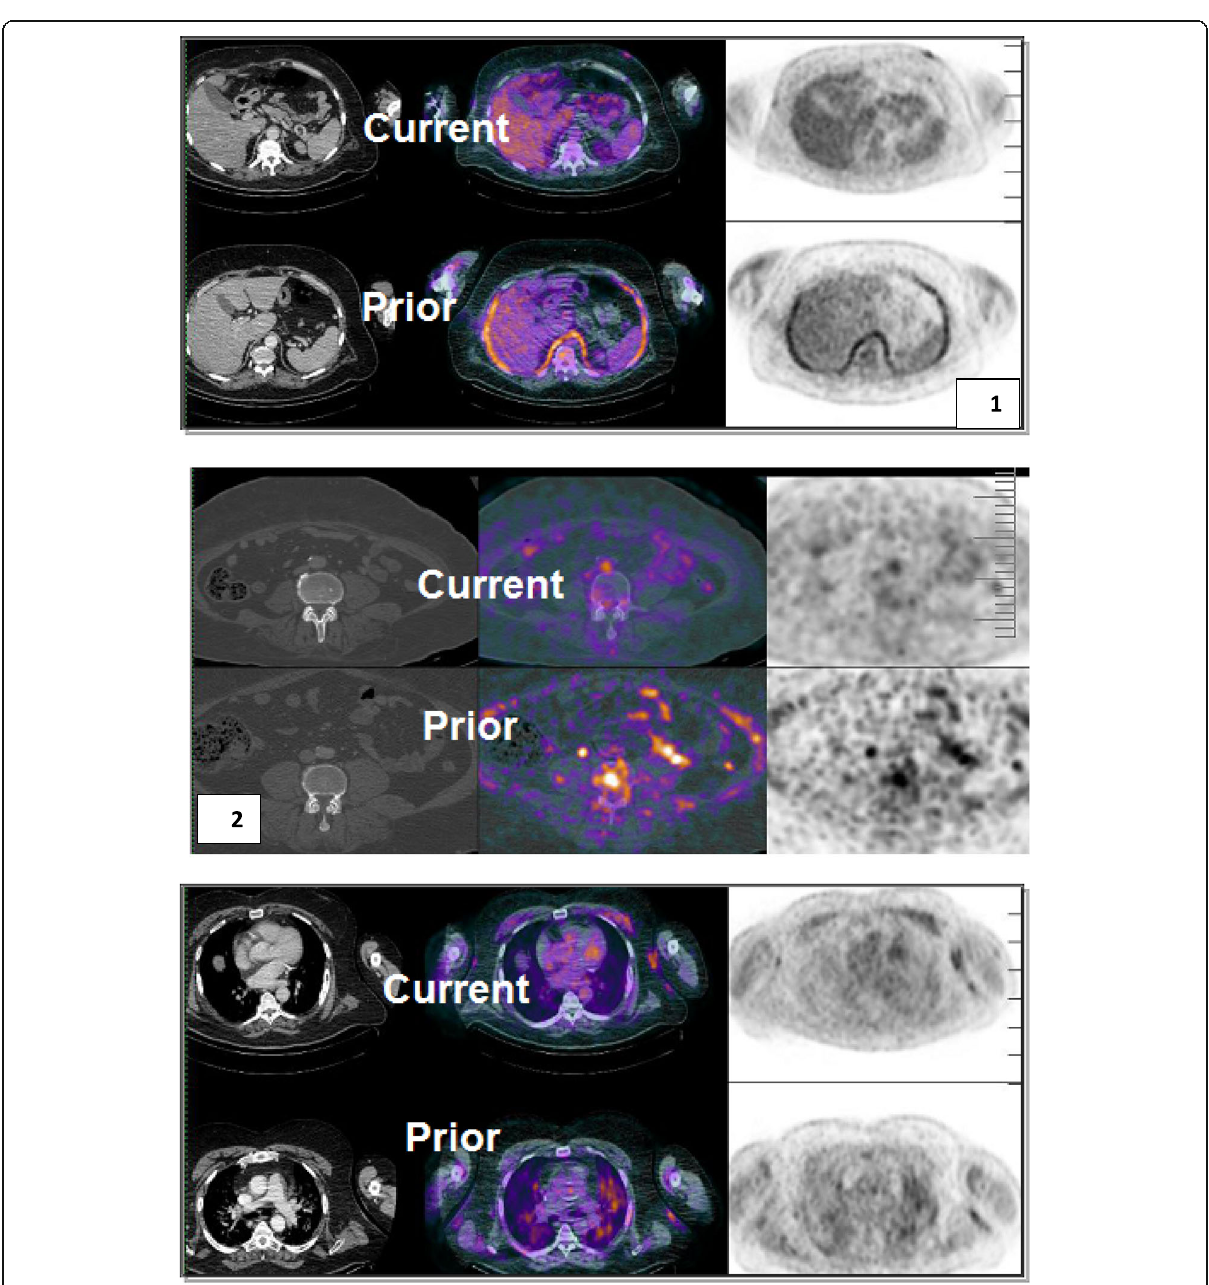
Fig. 3 1 Axial CT, PET, and PET/CT images showing regression of FDG avid chest wall lesions except for left anterior chest wall lesion (skin and subcutaneous tissue). 2 Axial CT, PET, and PET/CT images showing metabolic regression of FDG avid osseous lesions, involving sternum, vertebrae, pelvic bones, and femora. 3 Axial CT, PET, and PET/CT images showing metabolic regression of reticulonodular lung infiltration. Left chest wall skin nodular thickening at the operative bed with increased metabolic activity (locoregional